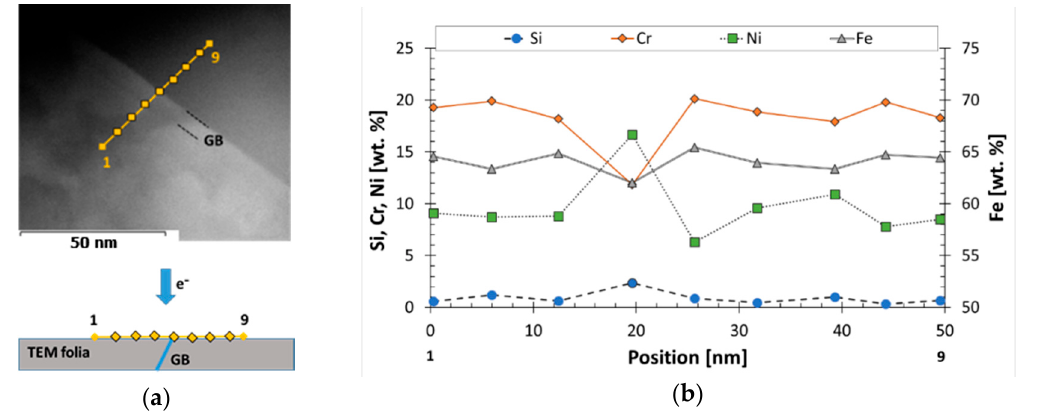
Figure 3. Scanning TEM Energy-dispersive X-ray spectroscopy (EDS) point analyses (from 1 to 9) in a marked line across a high-angle grain boundary of in-service irradiated 18Cr-10Ni-Ti of Russian PWR (WWER) RCI (5.2 dpa): ( a ) schematic showing position of the grain boundary (GB) in the TEM folia; ( b ) Depleted Cr and enriched Ni, Si was observed [6]. Copyright 2018 by The Minerals, Metals & Materials Society. Used with permission.